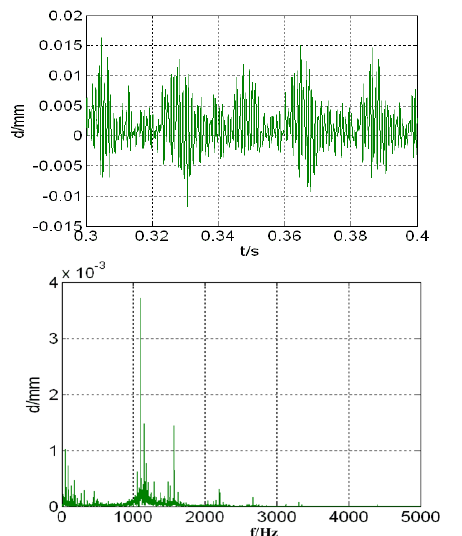
Fig.18. Vibration displacement of node 23451 in Z